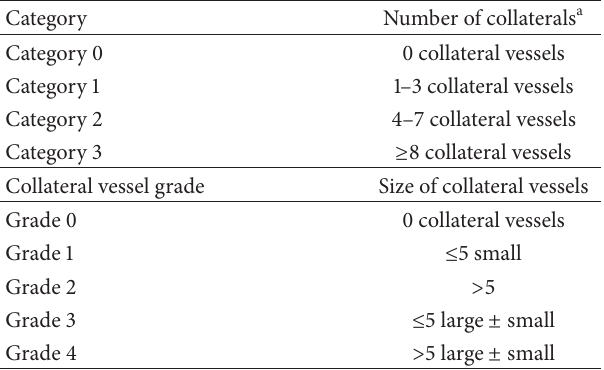
Table 3: Definition of the classification system used to quantify the collateral vessel number and size.